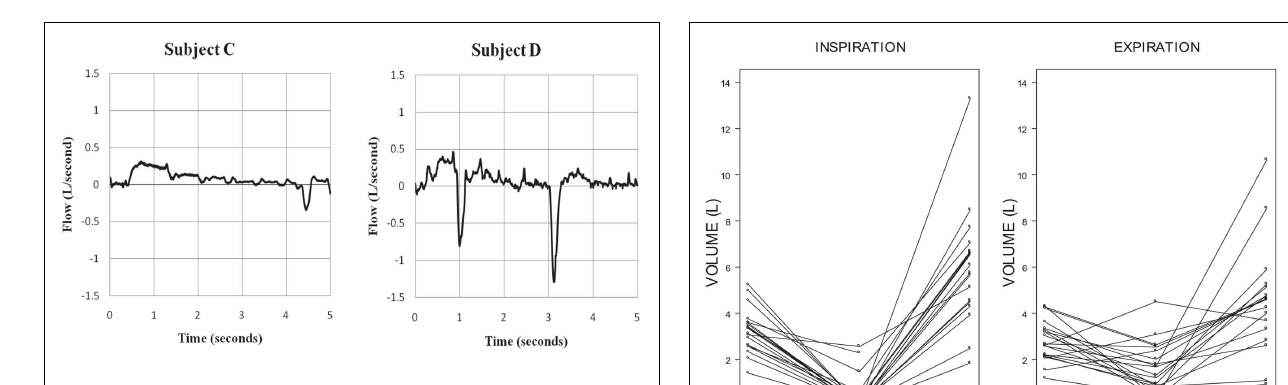
FIGURE 5 | Evidence of sniff behavior during ECD exposure. Subjects C and D showed evidence of sniff behavior during the ECD exposure period. Subject C self-reported trying to sniff during exposure, but was unsure of their success. Subject D was unsure in self-report about trying to sniff during exposure. Negative values represent inspiratory flow.